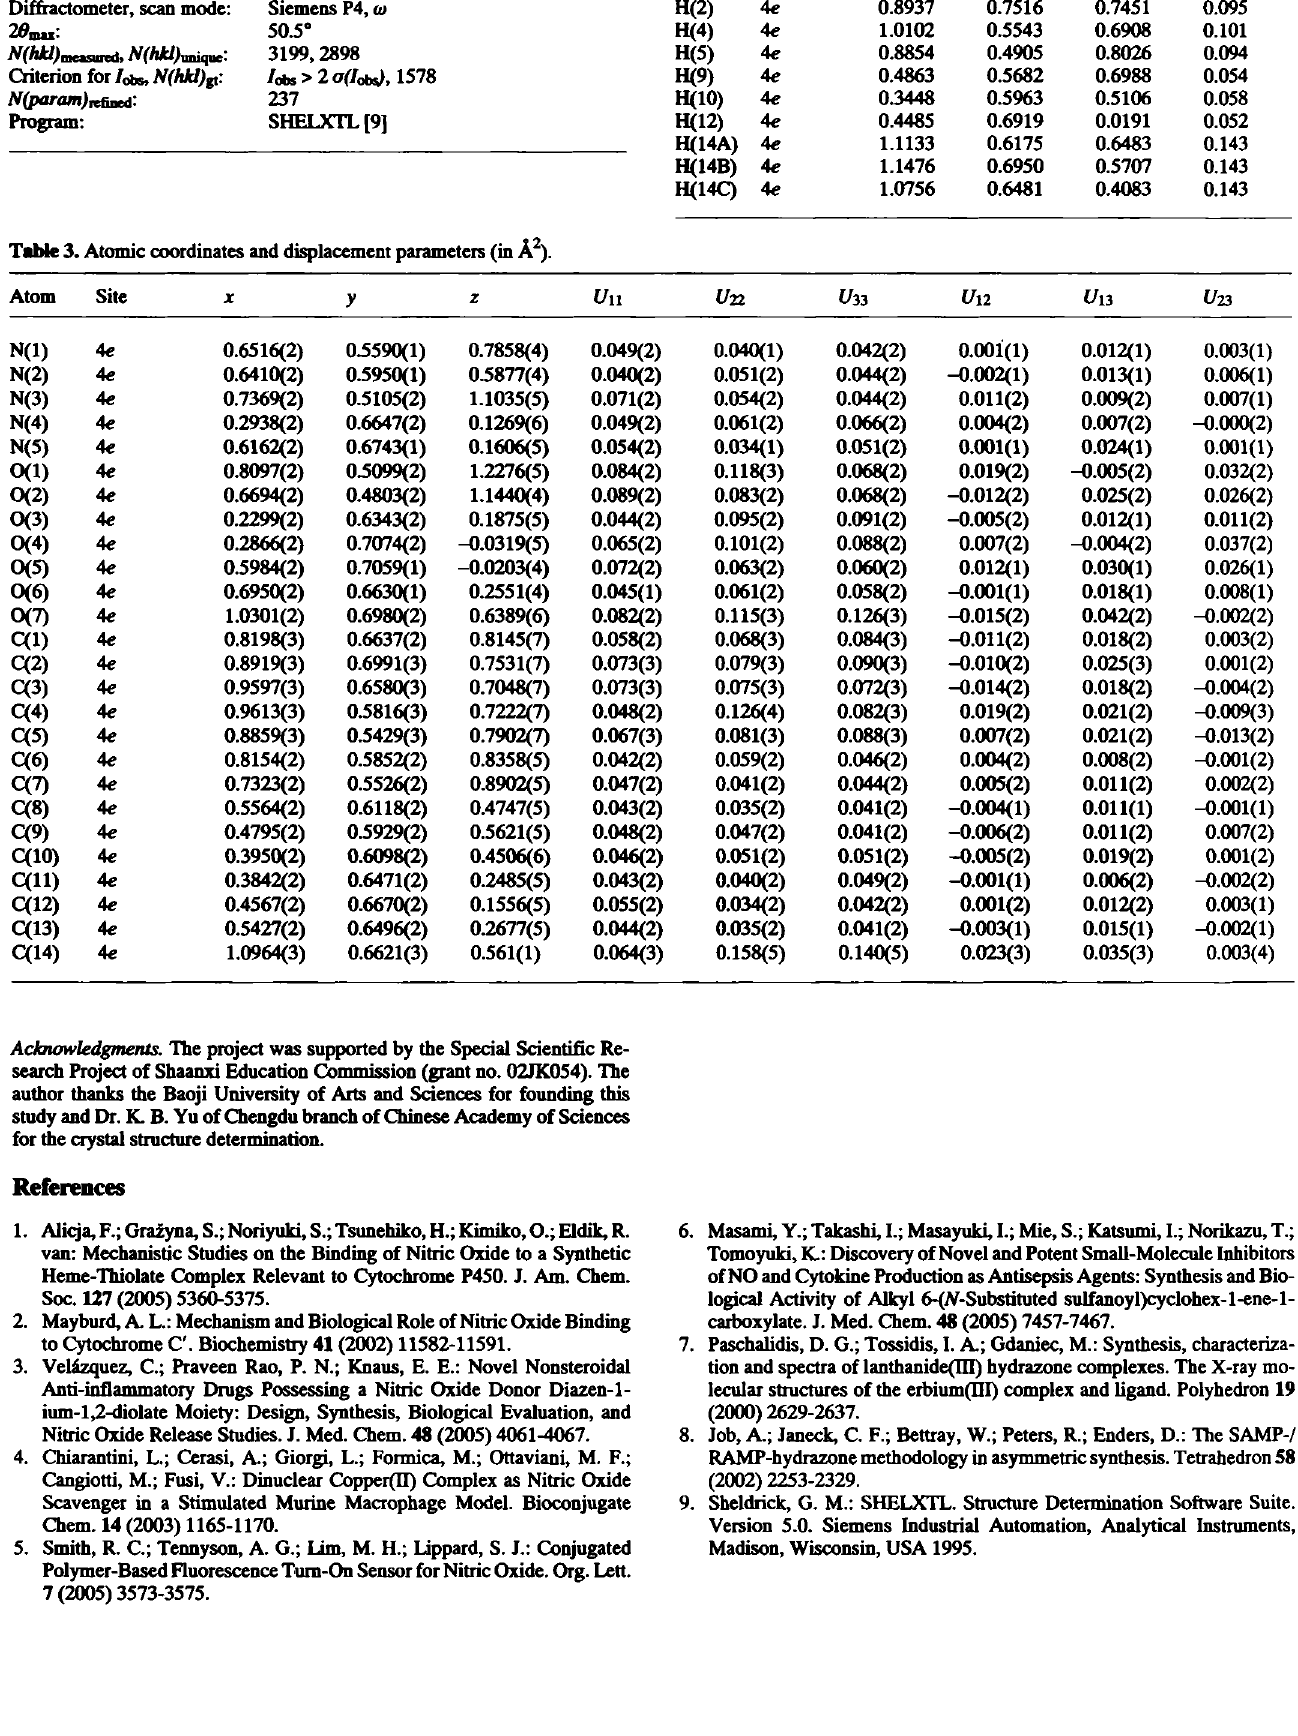
Table 3. Atomic coordinates and displacement parameters (in A 2